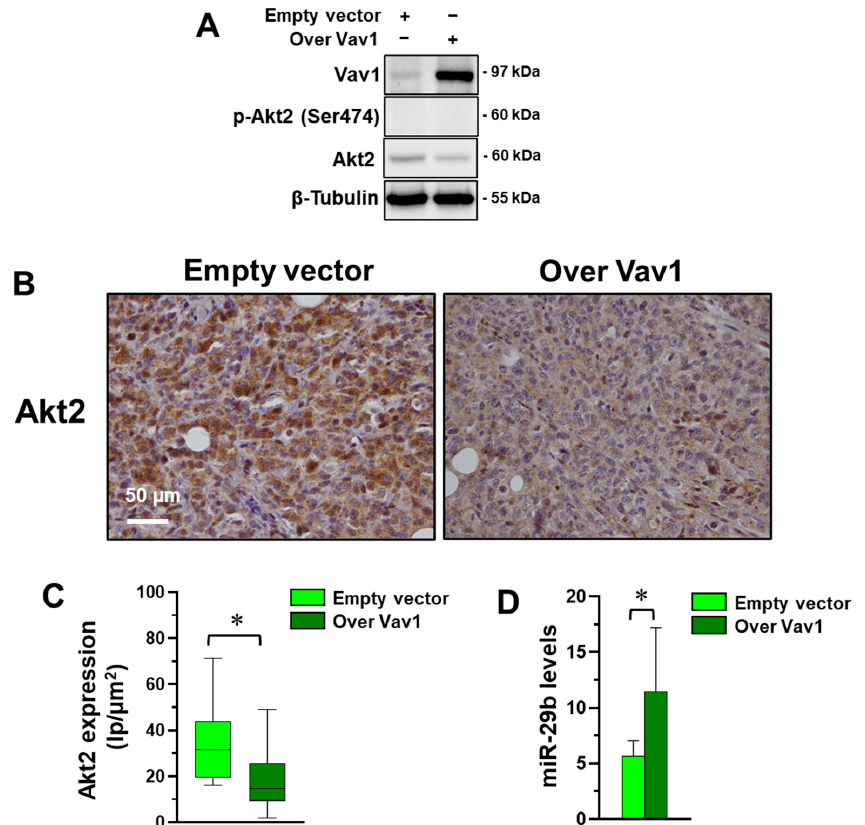
Figure 3. Correlation between Vav1, miR-29b and Akt2 in MDA-MB-231-derived xenografts. ( A ) Representative immunochemical analysis of MDA-MB-231 cells stably expressing an empty vector or Vav1. ( B ) Representative immunohistochemical analysis with the anti-Akt2 antibody of xenografts from the above-described MDA-MB-231 cells. ( C ) Analysis of Akt2 staining in xenografts that reports the Intensity of Positive pixels/Area (Ip/µm 2 ). ( D ) qRT-PCR analysis (2 −Δ Ct ) of miR-29b-3p in laser micro-dissected xenografts sections. * p < 0.05 between bars.